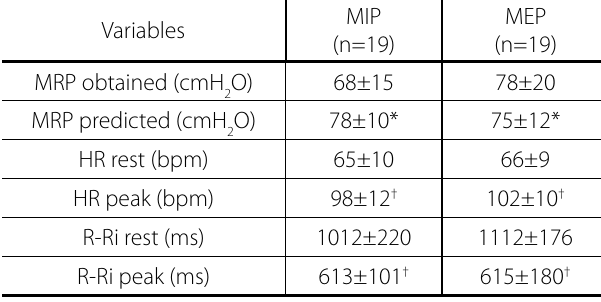
Table 2. Comparison of maximal respiratory pressures, heart rate and R-R intervals values under pre effort rest conditions and during maximal inspiratory and expiratory pressures